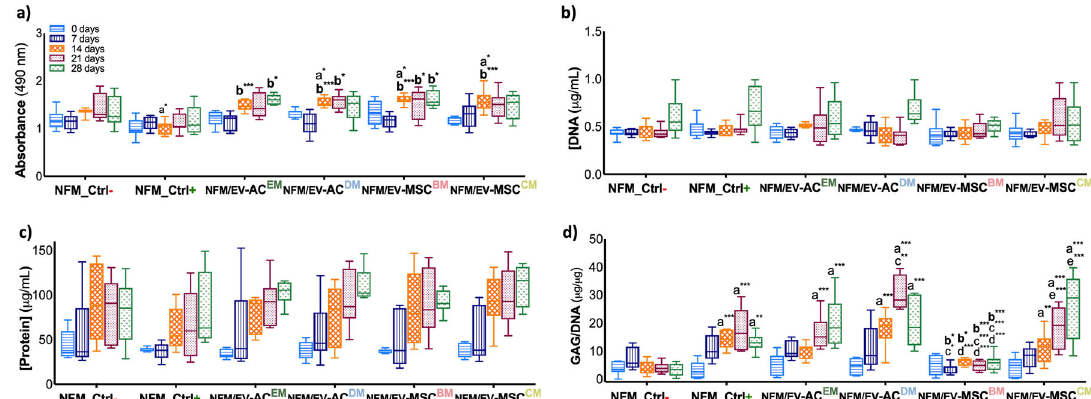
Fig. 4 Biochemical performance of cultured hBM-MSCs. Metabolic activity ( a ), proliferation (DNA content) ( b ), total protein synthesis ( c ), and sulfated glycosaminoglycan (GAGs) content normalized against DNA ( d ) of hBM-MSCs cultured on biofunctional nano fi brous systems comprising EVs derived from different sources (i.e., NFM/EV-AC EM , NFM/EV-AC DM , NFM/EV-MSC BM , and NFM/EV-MSC CM ), under basal culture conditions. hBM-MSCs cultured on non-biofunctionalized nano fi brous substrates under basal medium ( NFM_Ctrl − ) or chondrogenic medium ( NFM_Ctrl + ) were used as controls. Data are represented in box plot and analyzed by Kruskal – Wallis test, followed by the Tukey ’ s HSD test (* p < 0.01; ** p < 0.001; *** p < 0.0001): a denotes signi fi cant differences compared to NFM_Ctrl − ; b denotes signi fi cant differences compared to NFM_Ctrl + ; c denotes signi fi cant differences c ompared to NFM/EV-AC EM ; d denotes signi fi cant differences compared to NFM/EV-AC DM ; e denotes signi fi cant differences compared to NFM/EV-MSC BM